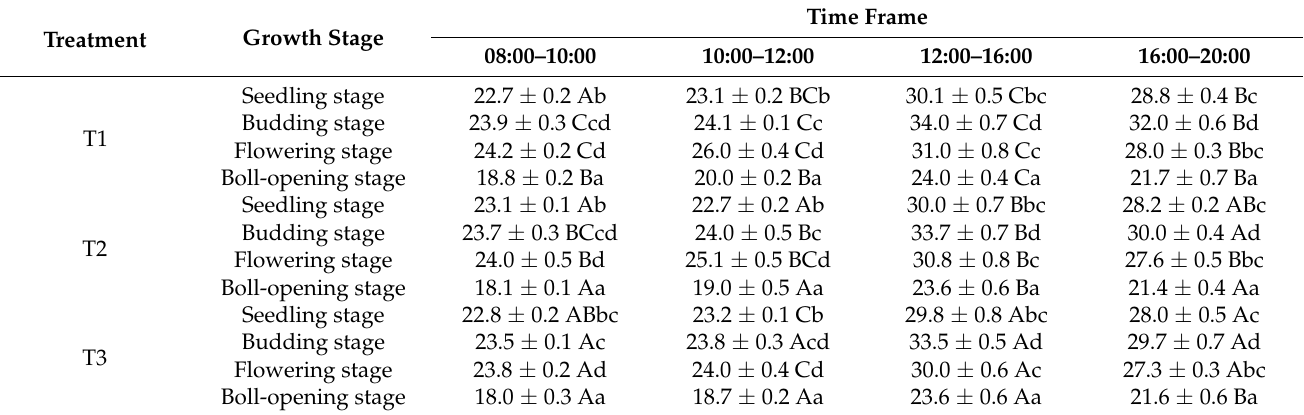
Table 3. Effects of different irrigation methods on soil temperature.